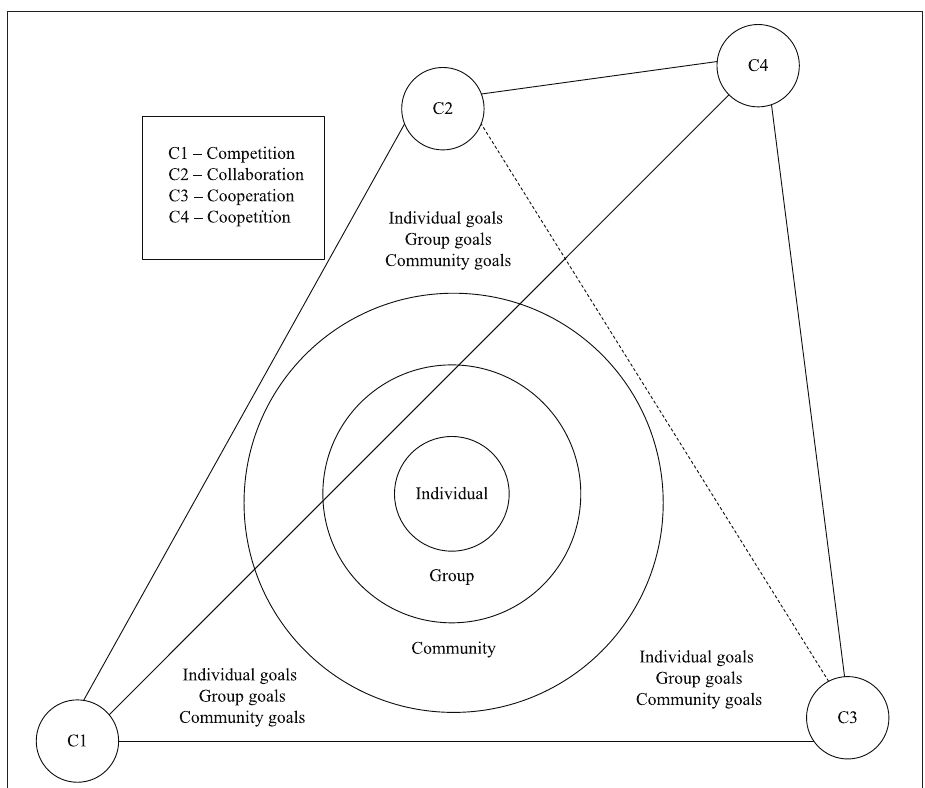
Figure 3. A model of consistency among competition, cooperation and collaboration